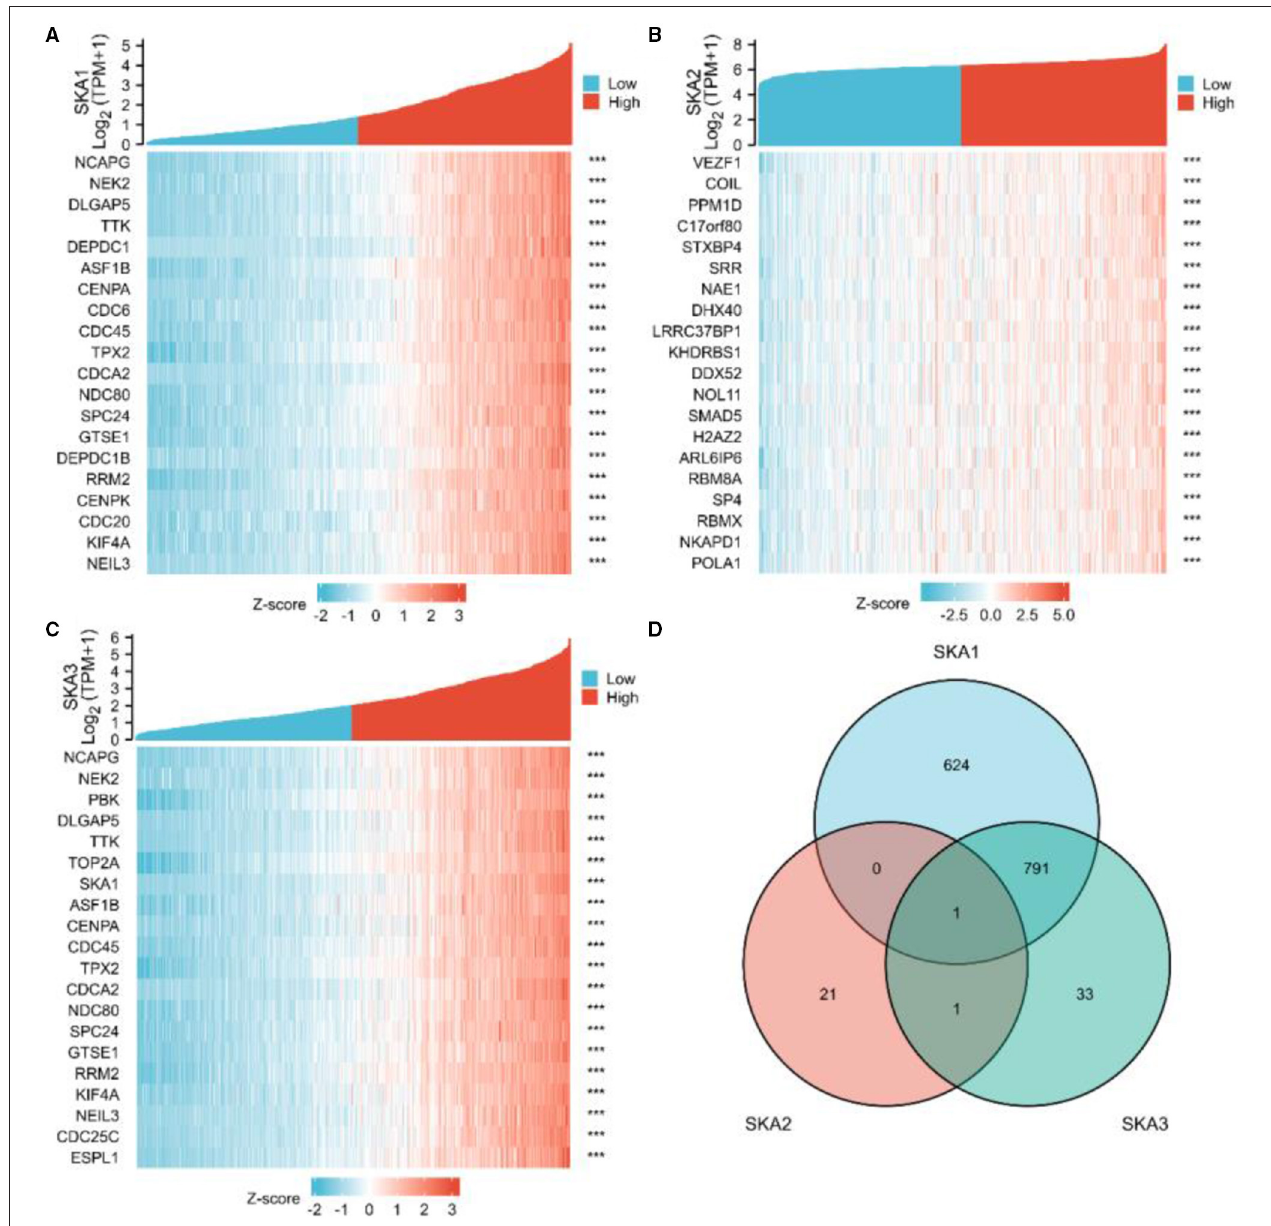
FIGURE 6 | Identification of genes co-expressed with the SKA complex. Expression patterns from The Cancer Genome Atlas (TCGA) database are shown for the top 10 upregulated and the top 10 downregulated genes significantly correlated with the expression of SKA1 (A) , SKA2, (B) , and SKA3 (C) in gliomas. The intersection of co-expression patterns identifies the genes co-expressed with the SKA complex (D) . The threshold values are |r| > 0.6 and P -value <